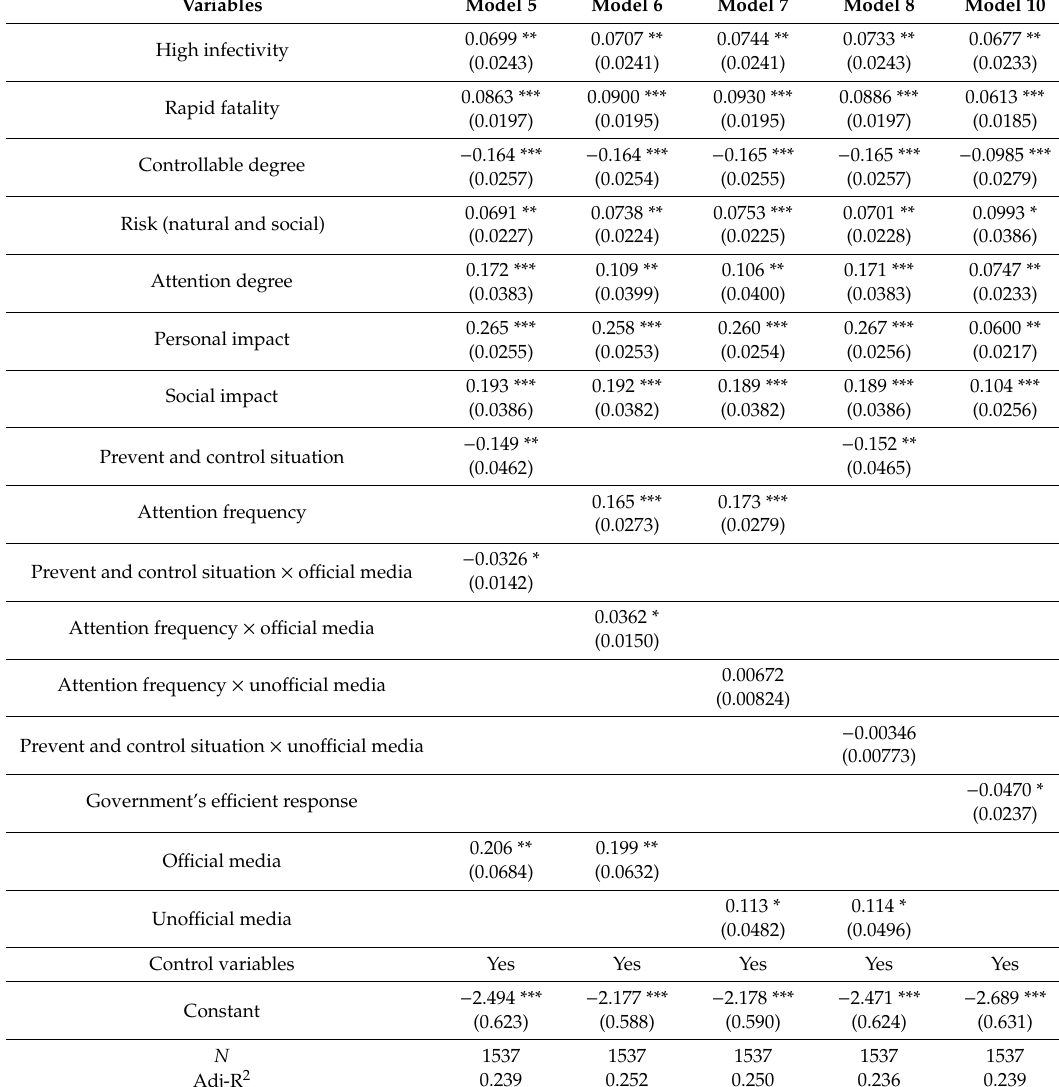
Table 4. Regression models of media use and